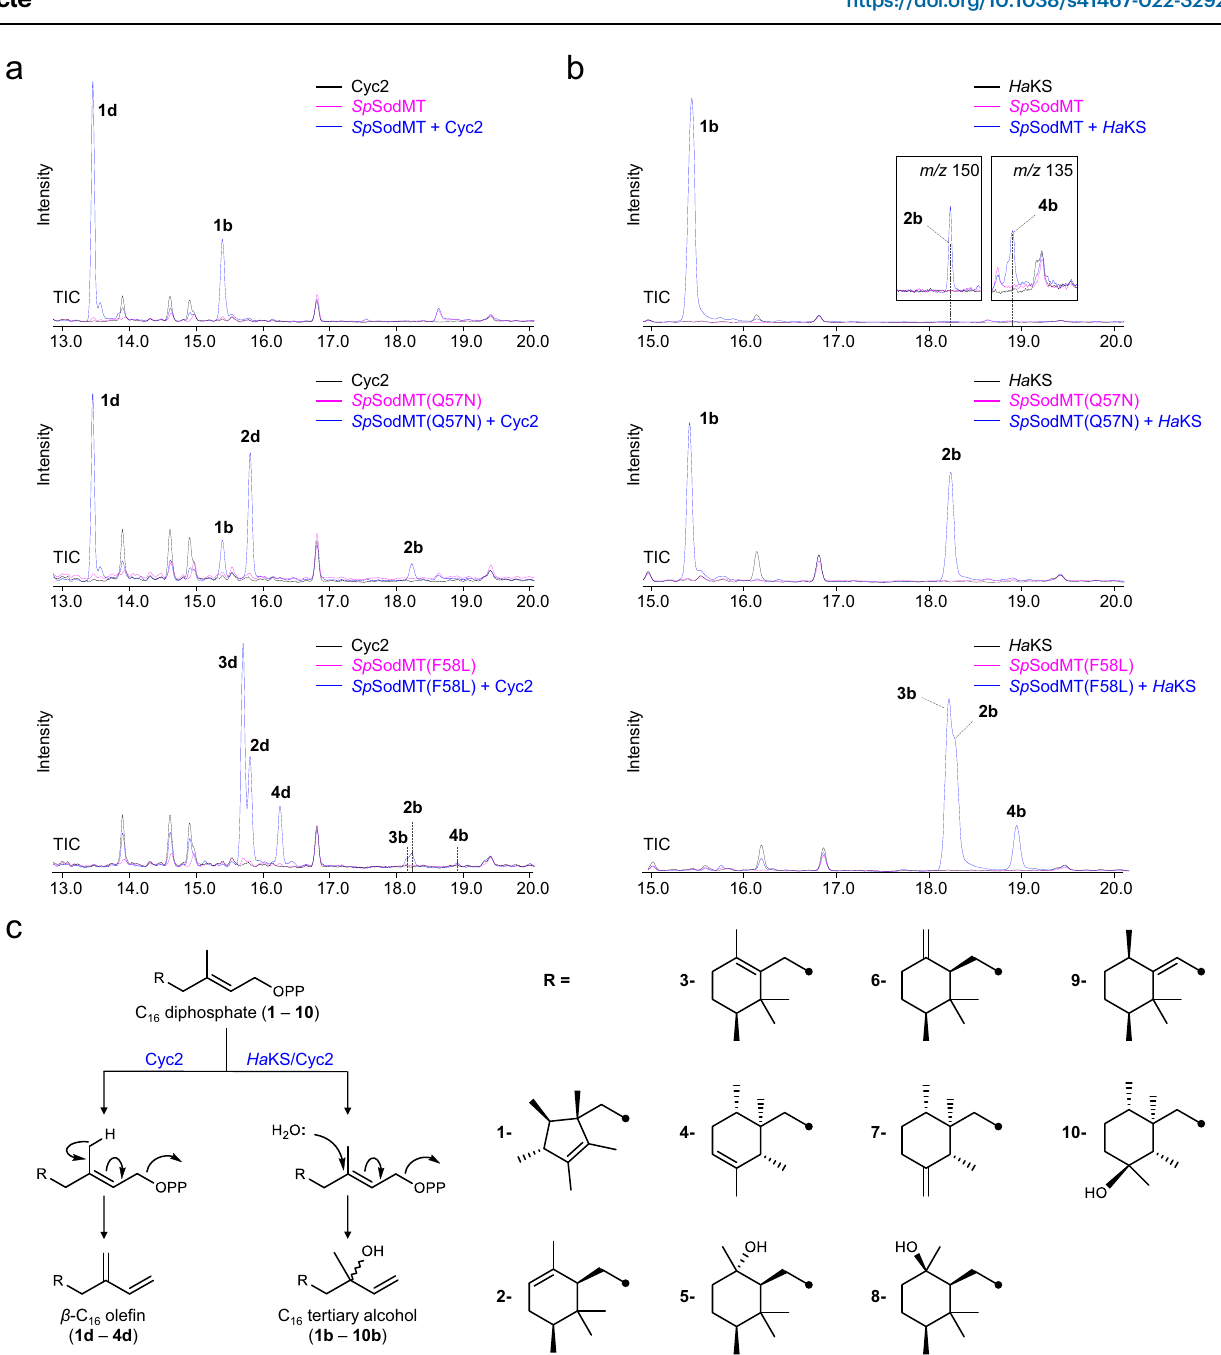
and 2b from PSPP and PPP, respectively. A blend of tertiary alcohols, including 2b , 3b , and 4b , were produced in cells expressing the promiscuous Sp SodMT(F58L) variant. In both panels a and b , yeast cells were cultivated in buffered media to prevent hydrolysis of excess prenyl diphosphates in acid- i fi ed media during cultivation. c Proposed mechanism of Cyc2 and Ha KS reactions using C 16 diphosphates. In a reaction that involves an ionization- initiated cyclization cascade followed by deprotonation, Cyc2 converts the non-canonical building blocks to the corresponding C 16 ole fi ns. Ha KS, and to a lesser extent Cyc2, produce non-canonical tertiary alcohols by addition of watertoC 16 tertiarycarbocationintermediates.Changesintheretentiontimes of speci fi c compounds in Fig. 5 as compared to those in Fig. 4 are due to different temperature program (GC analysis method 2, used in Fig. 5 vs. GC analysis method 1, used in Fig. 4) and instrument used in the current